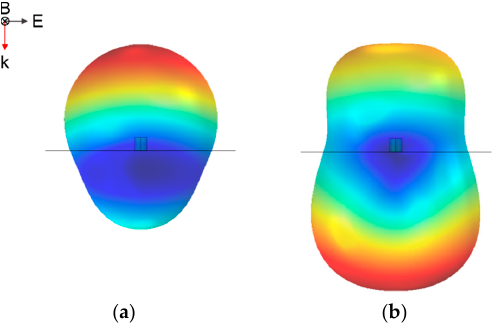
Figure 2. Far-field scattering (being as highest the intensity as reddish the color in a rainbow scale) of an individual nanoparticle ( h = 160 nm, r = 72 nm) satisfying the minimum forward condition at λ = 632.8 nm, deposited over ( a ) a low refractive index substrate (aerogel) or ( b ) glass substrate.